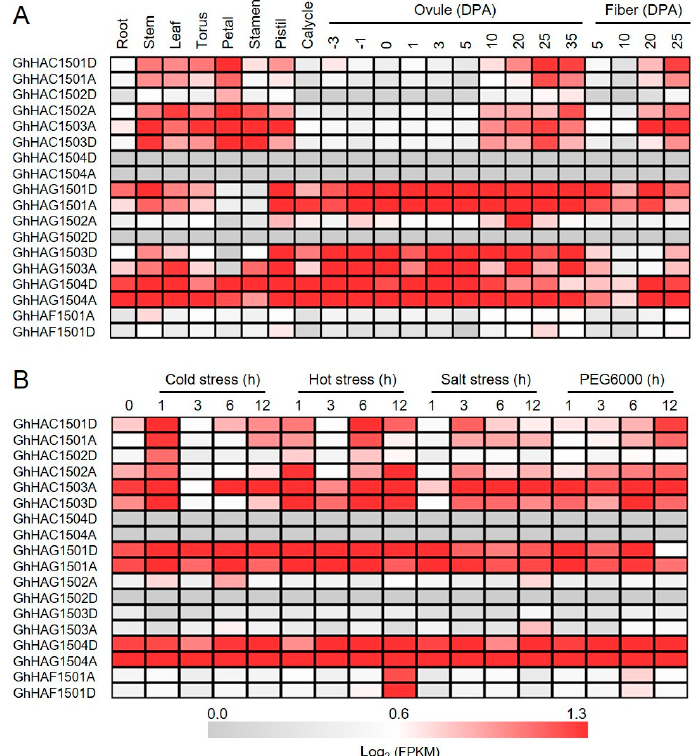
Figure 4. Gene expression pattern of Gossypium hirsutum HATs by the analysis of RNA-sequencing in different tissues and at different stages of fiber development ( A ) and in response to cold, hot, salt, and polyethylene glycol (PEG) 6000 stresses ( B ). The illumina reads of RNA-seq data were retrieved from the National Center for Biotechnology Information Sequence Read Archive (NCBI SRA) database. The color scale at the bottom of heat map indicates the fragments per kilobase million (FPKM)-normalized log2 transformed counts.